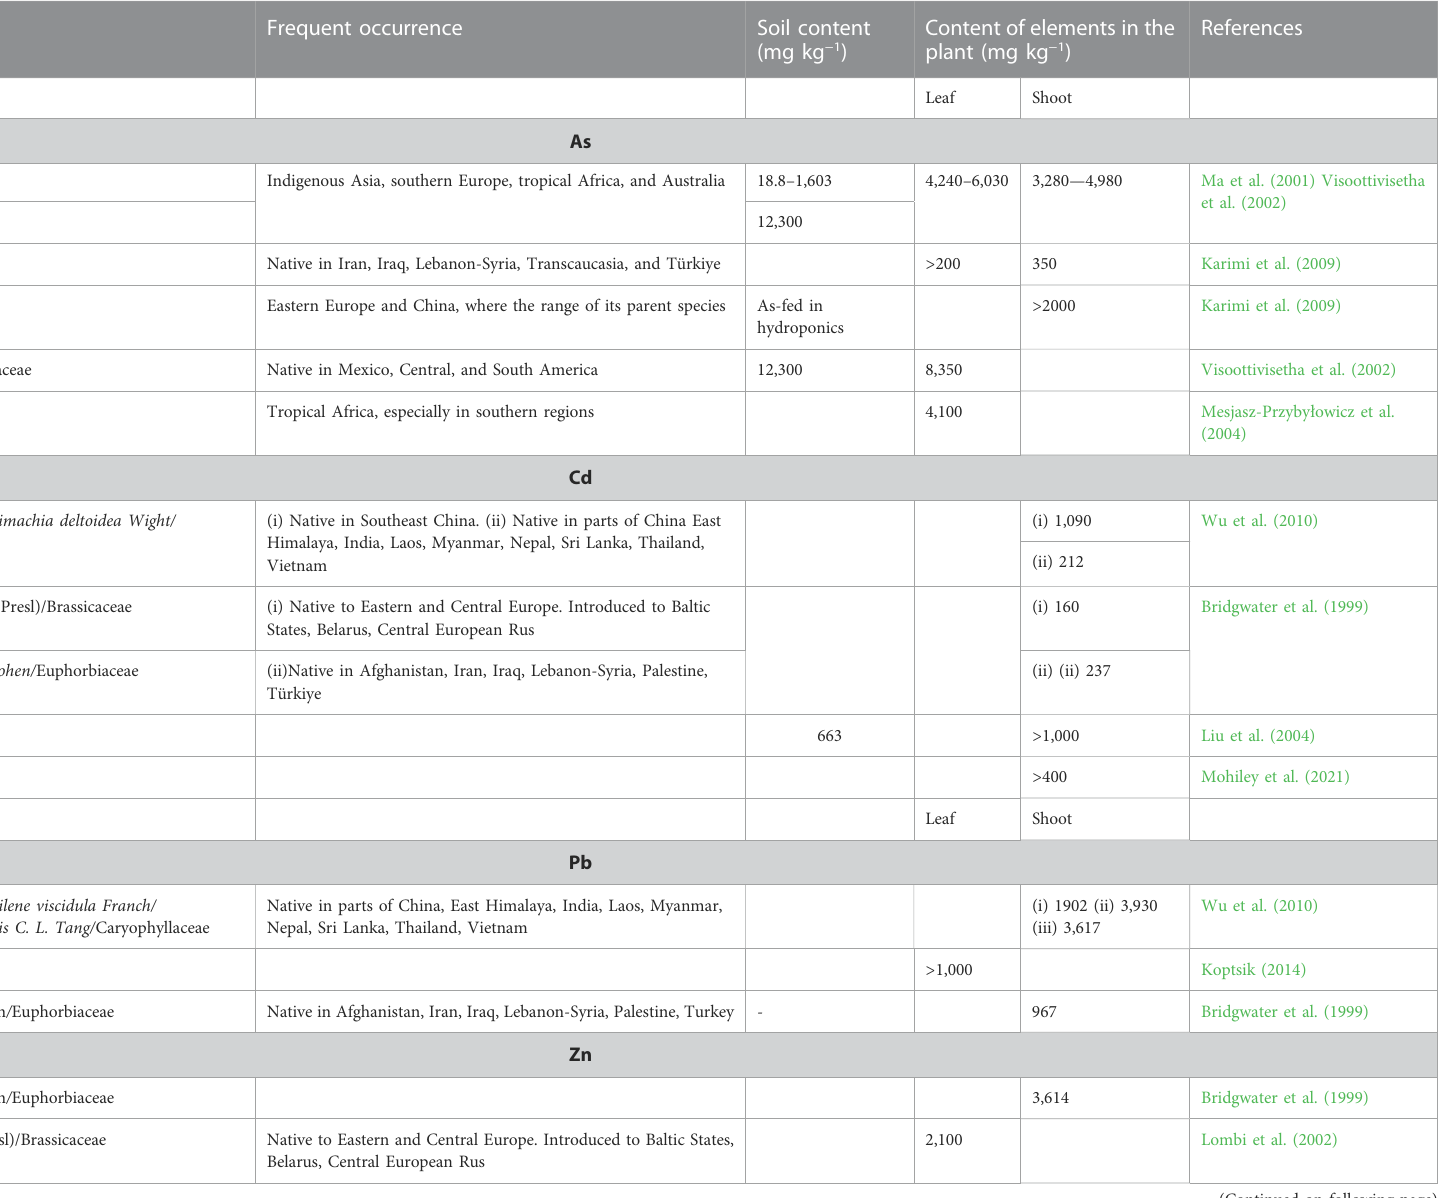
TABLE 1 Contents of As, Cd, Pb, and Zn in plant hyperaccumulators from different